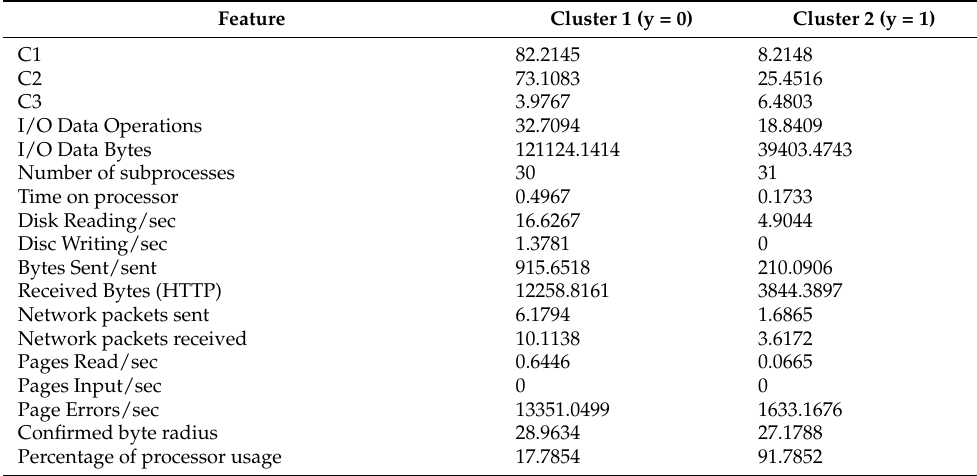
Table 4. Values of the features of representatives of clusters.